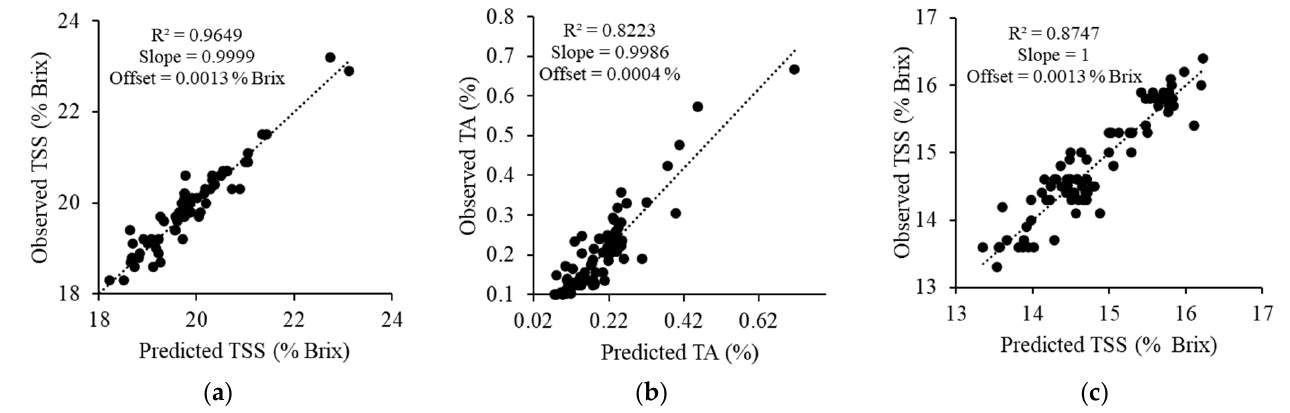
Figure 3. Scatter plots of predicted vs. observed TSS and TA of mango purée by PLSR ( a , b ) and TSS of mangosteen purée by PLSR ( c ). of mangosteen pur é e by PLSR ( c